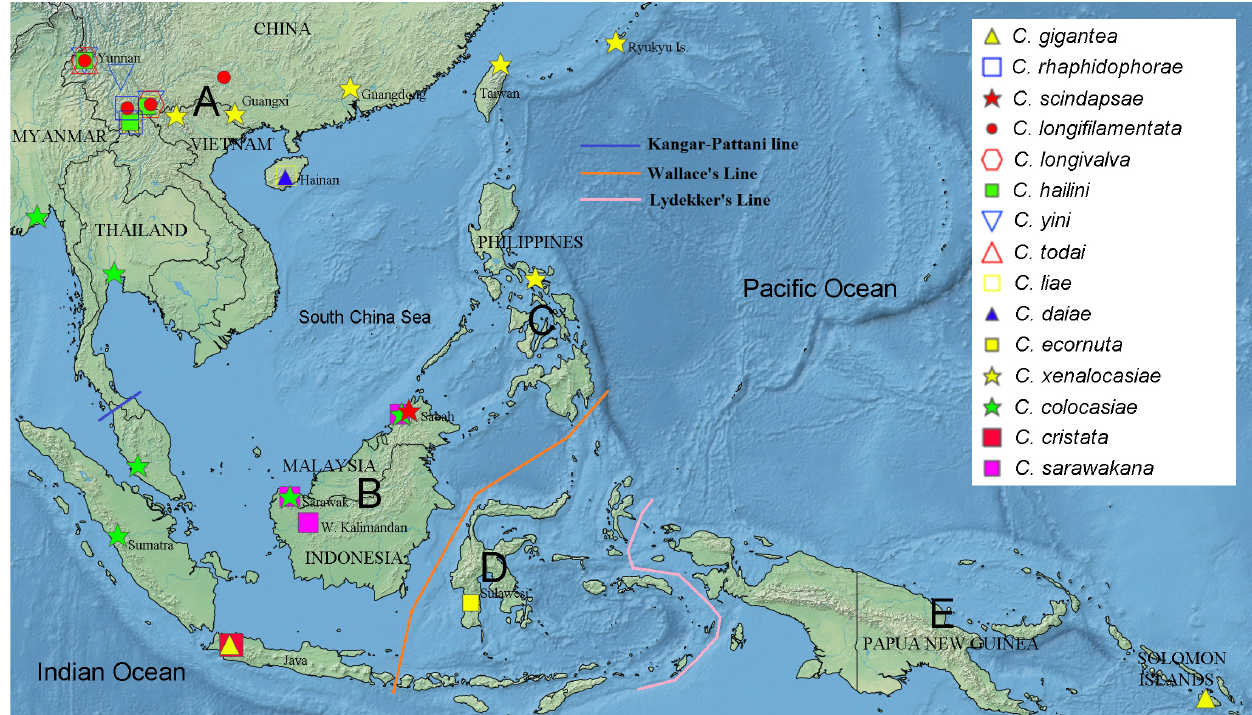
Figure 1. Division of the five areas (A: NE Oriental region, B: Sundaland, C: the Philippines, D: Wal- lacea, E: Australian region) employed in the biogeographical analysis. Records of geographic dis- tributions of all known species in the C. gigantea group and five representative species of C. cristata group employed in the present study are shown with legends on the map (created with Simplemappr (http://www.simplemappr.net/; accessed on 28 May 2022).